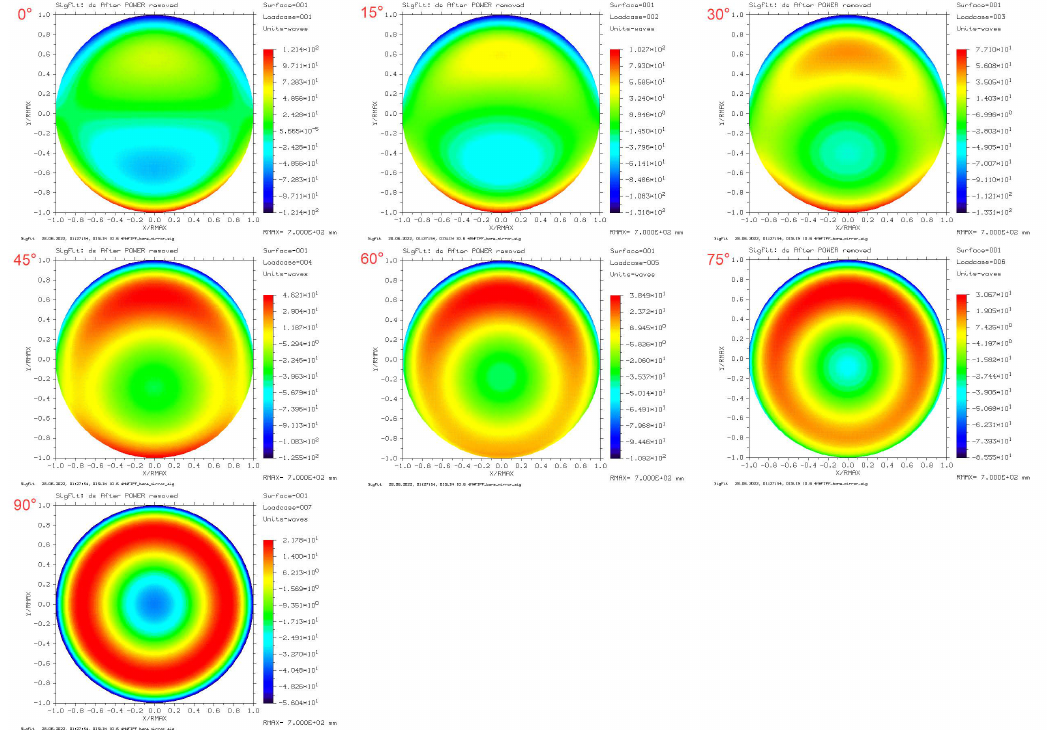
Figure 11. Normalized surface after removing defocusing of